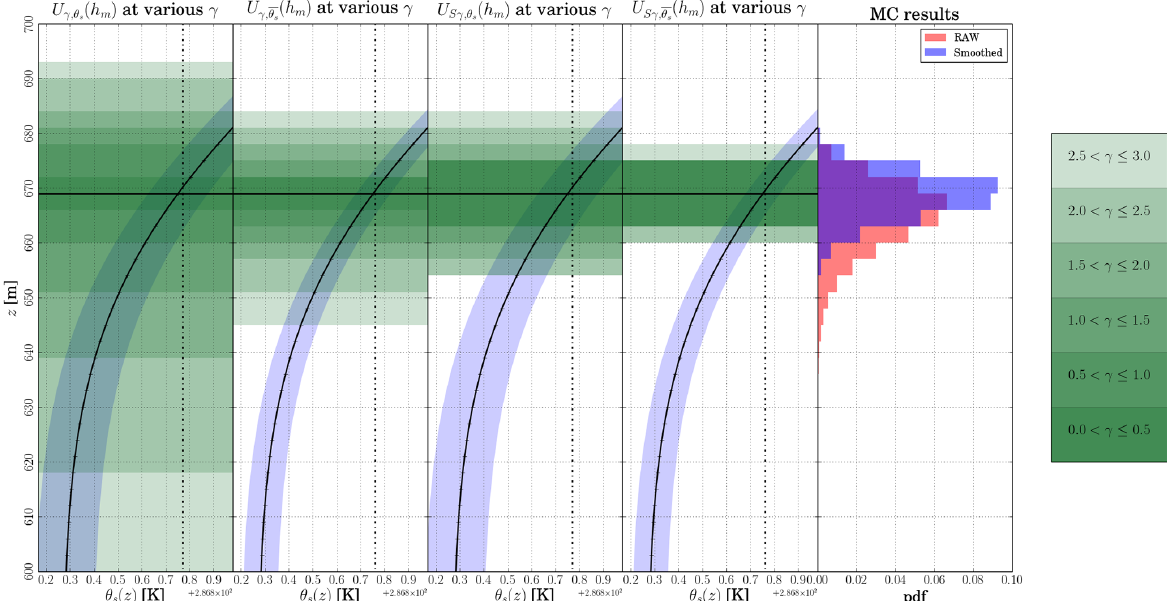
Figure 3. All plots are obtained starting from the synthetic profile θ s (z) introduced in Fig. 1 and calculated with spatial resolution of 3m. The first panel presents confidence neighborhoods as from Eq. (4) for various thresholds γ ; second panel presents the confidence neighborhoods for the smoothed profile θ s (z) ; third panel: strict confidence neighborhoods as from Eq. (5); forth panel: strict confidence neighborhoods as from Eq. (5) for the smoothed profile θ s (z) ; fifth panel: probability density function of the Mote Carlo results for the algorithm introduced in Sect. 2.1 for raw data (red) and smoothed (blue). The confidence neighborhoods are depicted as green areas, following the color scale on the right. The horizontal black line represent the location on the MH = h m = 669m for this spatial